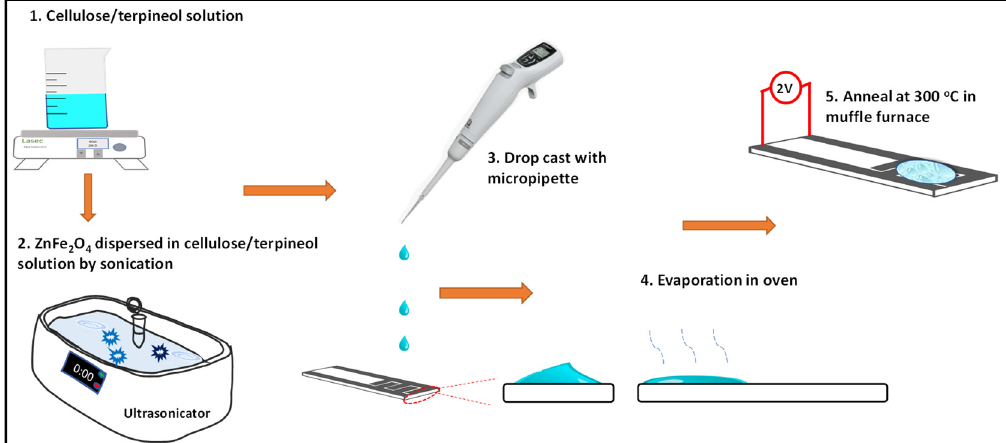
Figure 1. Fabrication process followed to produce ZnFe 2 O 4 NP-based sensing layer films using a drop-casting method.